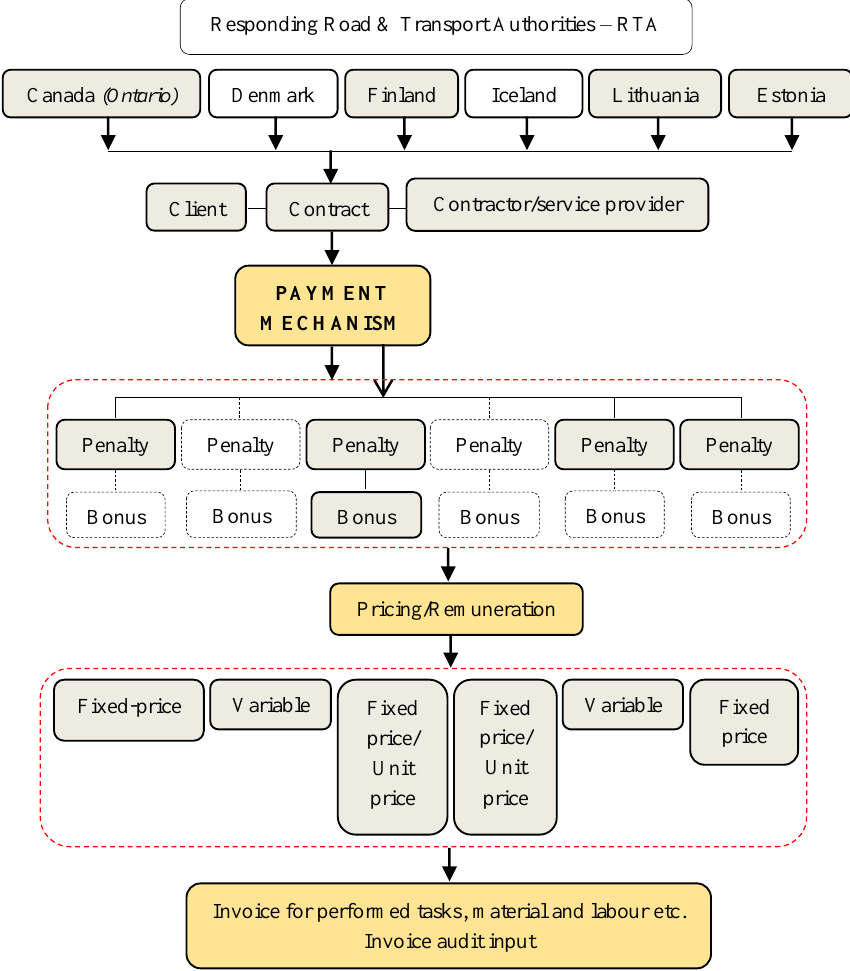
Figure 3 Schematic representation of the payment mechanism in the studied